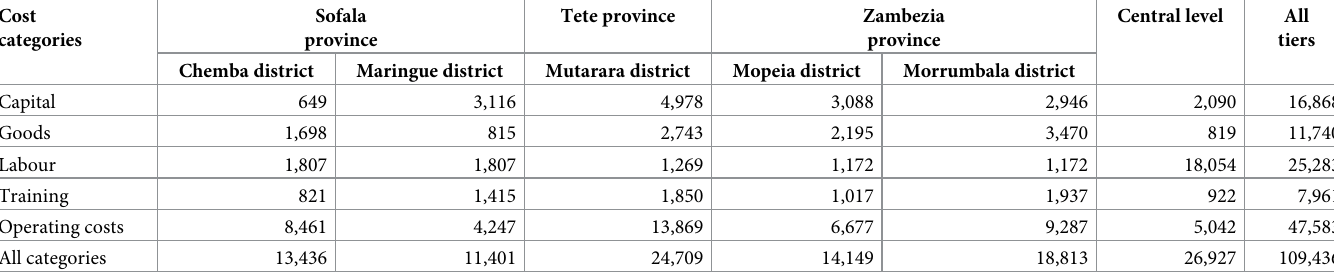
Table 1. CGAAS: Summary of the agricultural services programme costs, by location and category. Cost categories